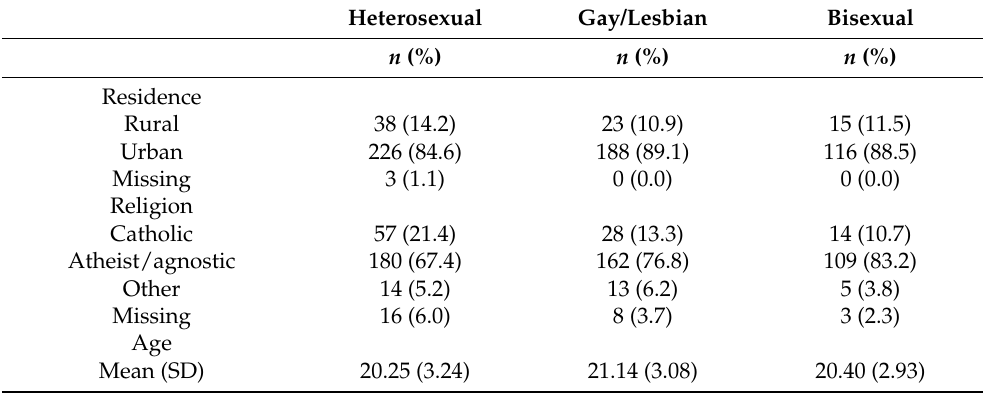
Table 1. Demographic characteristics of participants by sexual